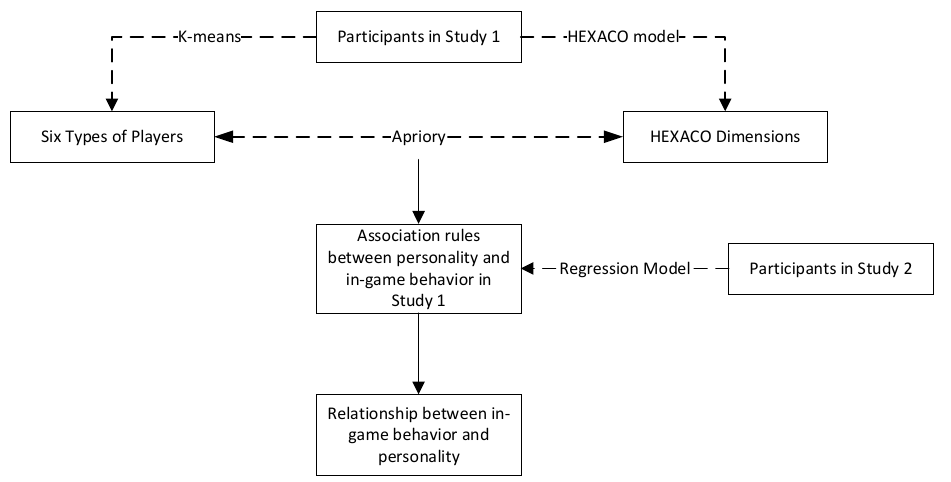
Figure 1. Research